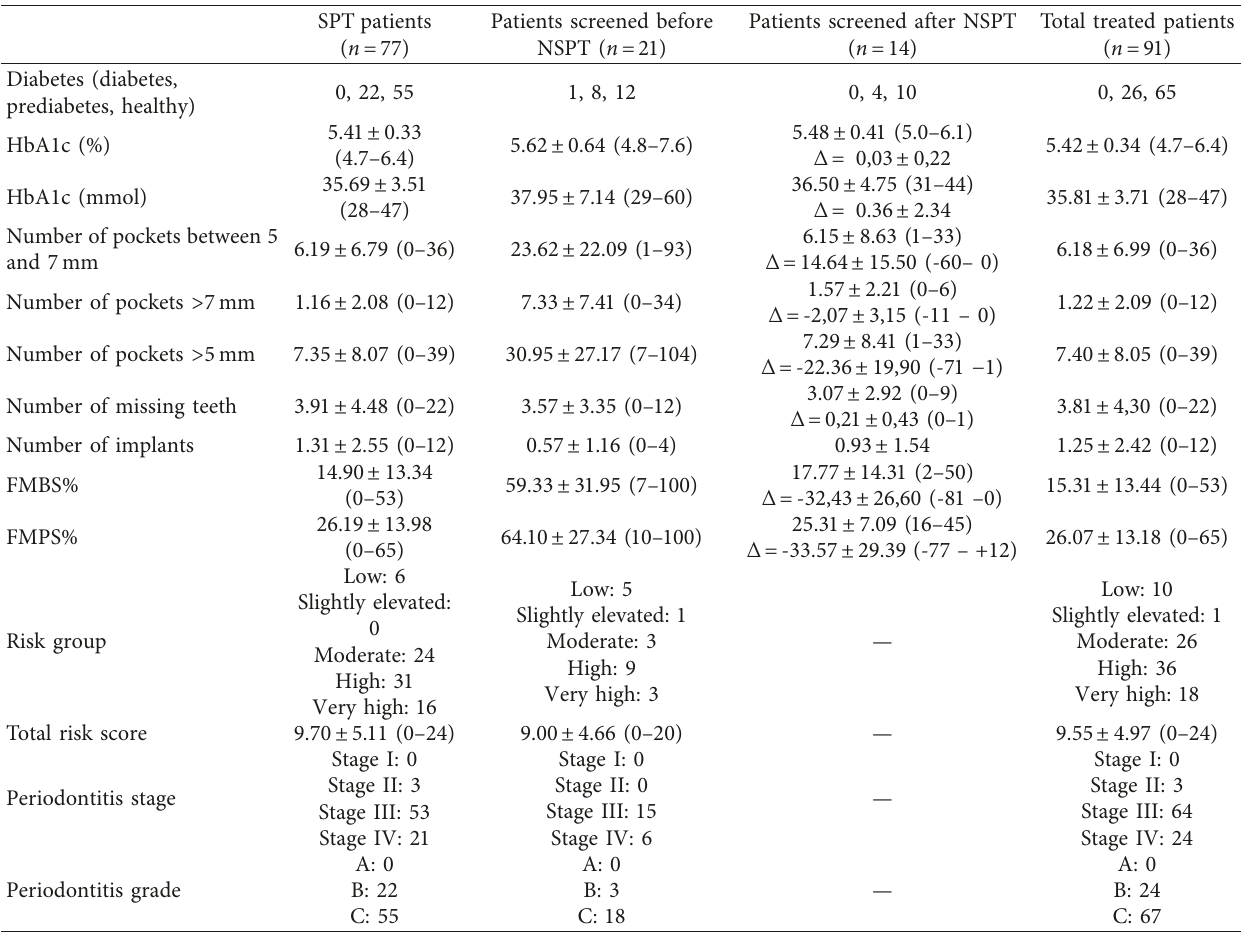
Table 1: Results of HbA1c levels and periodontal parameters expressed by means of frequencies or the mean ± standard deviation (min–max). For patients who repeated the screening after NSPT, differences between initial and final parameters are also reported.